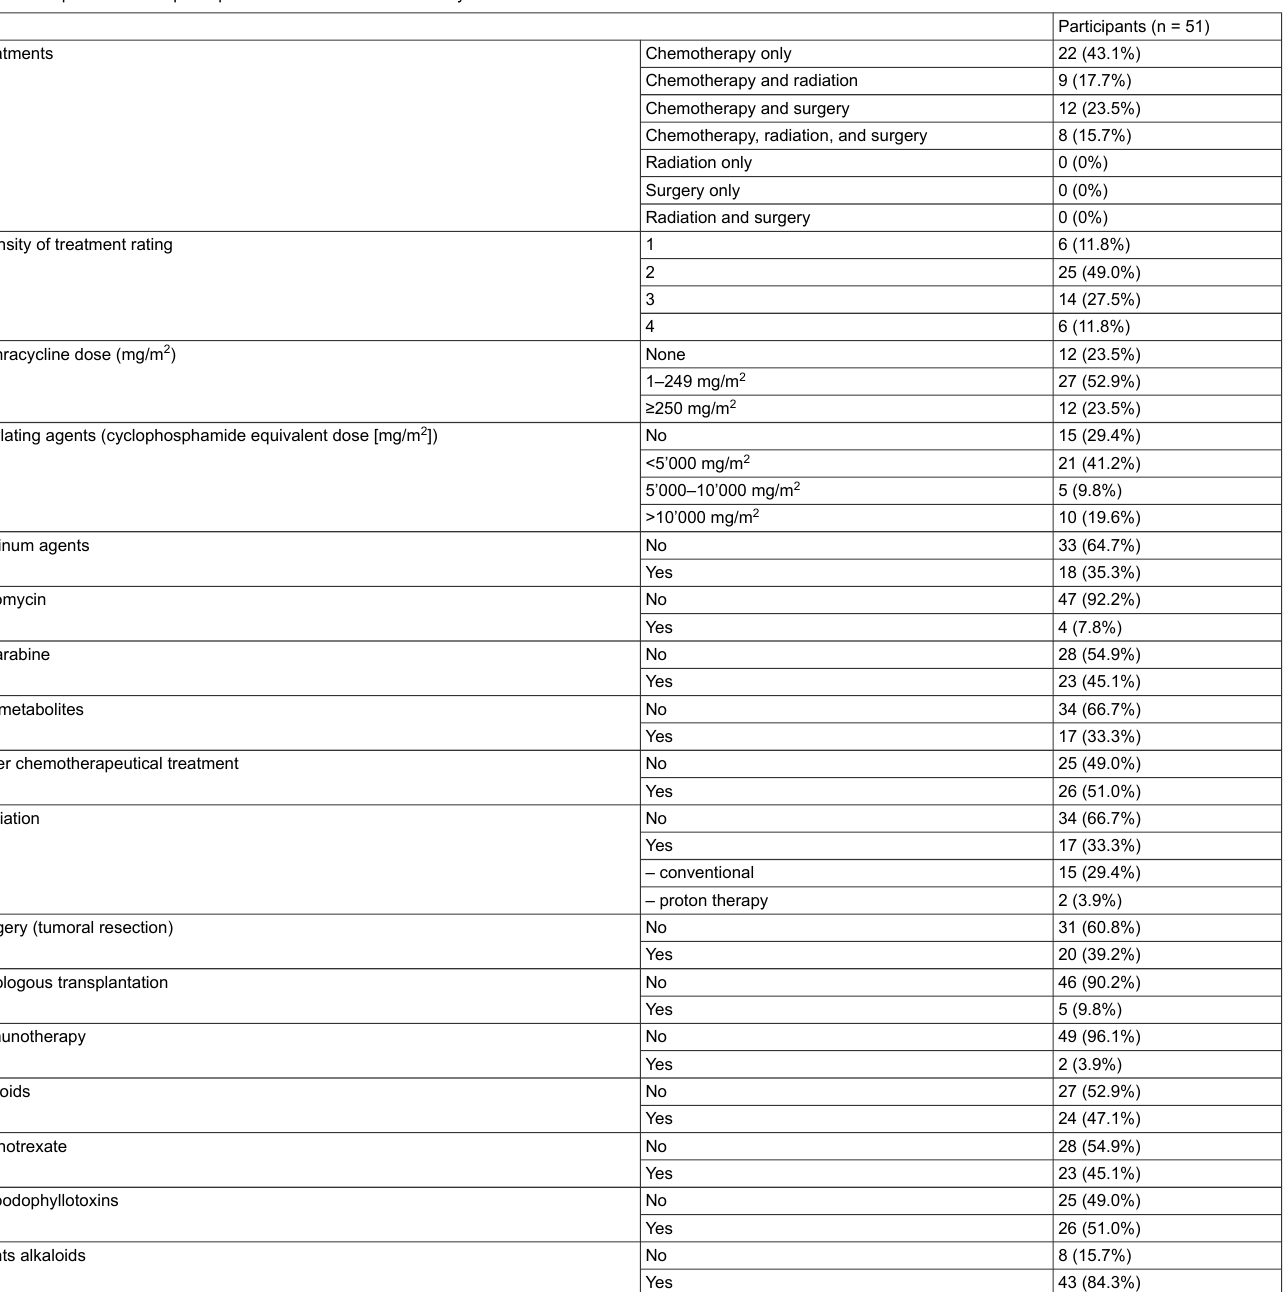
Table S2: Treatment exposures of the participants in the LTFU outcome